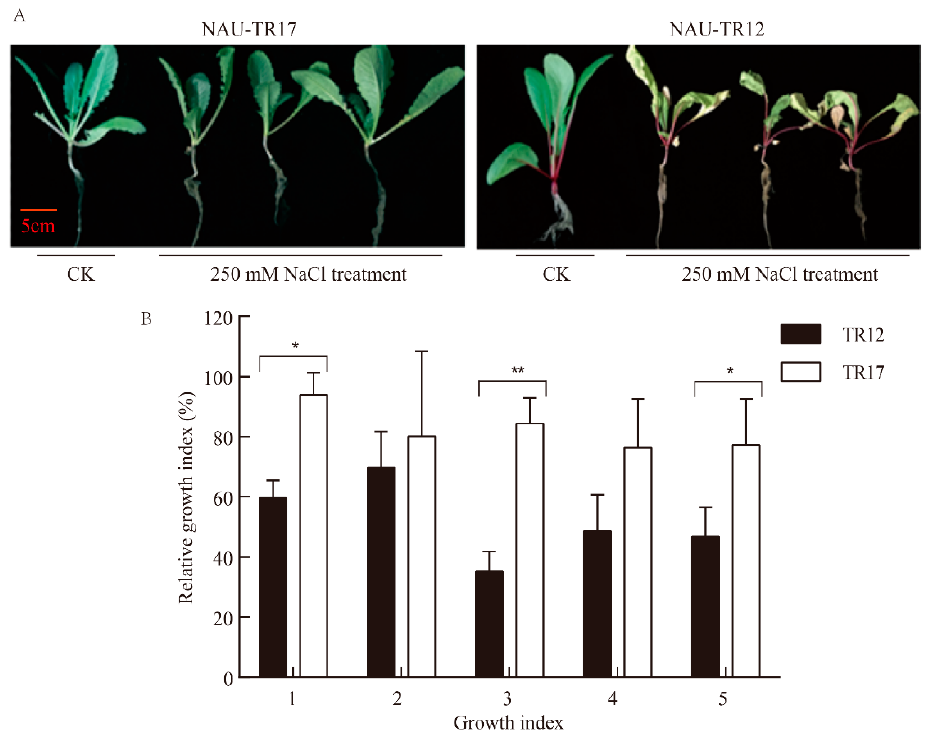
Figure 3. Salt tolerance evaluation of radish genotypes: ( A ) Phenotypic identification of salt tolerance; ( B ) Growth indexes under 250 mmol/L NaCl treatment. 1–5 represents relative plant height, root length, fresh weight of shoot, fresh weight of root and biomass, respectively. * and ** means differ significantly ( p < 0.05 and <0.01, respectively).